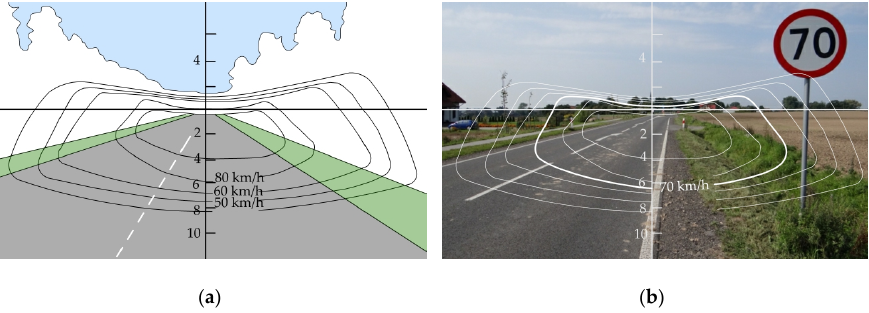
Figure 10. Driver’s visual attention area: ( a ) using the data from [15]; ( b ) with a 70 km / h speed limit indicated on the B-33 sign.